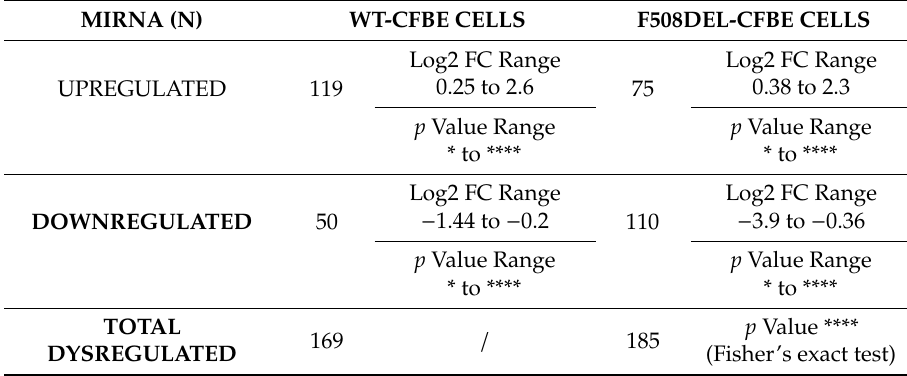
Table 2. Contingency table comparing the number of miRNAs significantly changed by TGF- β 1 in WT-CFBE and F508del-CFBE cells. Data are from the small RNA-seq experiments in WT- and F508del-CFBE cells. F508del-CFTR modulated how TGF- β 1 changed the miRNA landscape. The range ofLog2FCand p valuesarefortheexpressionofindividualmiRNAsintheTGF- β 1versusvehicle-treated groups. N = 6 in triplicates from six di ff erent cultures / group. * p < 0.05; ** p < 0.01; *** p <